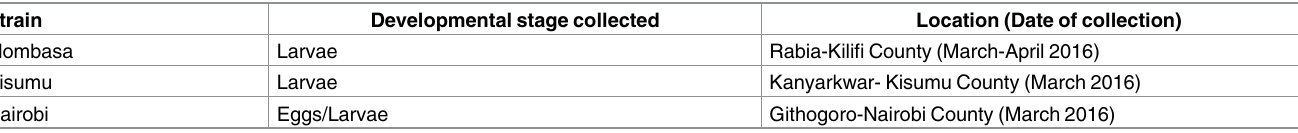
Table 1. Aedes aegypti strains tested for susceptibility to chikungunya virus.